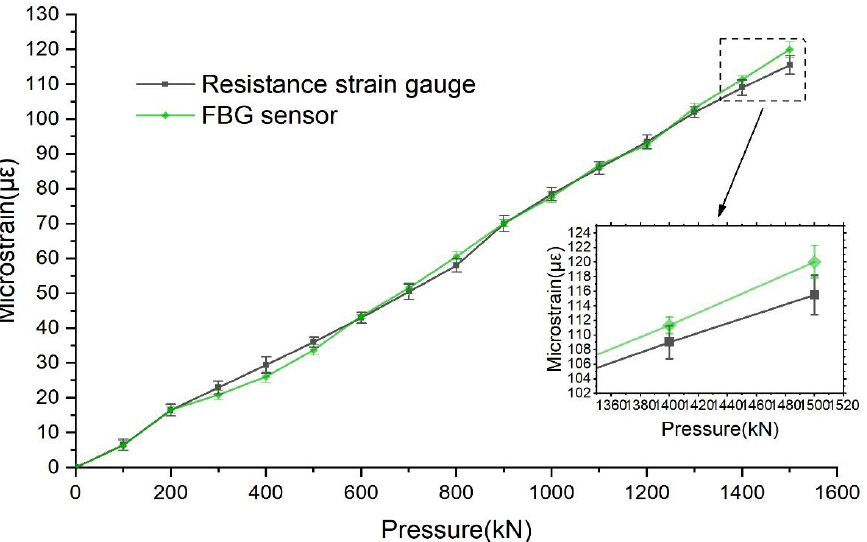
Sensors 2022 , 22 , x FOR PEER REVIEW